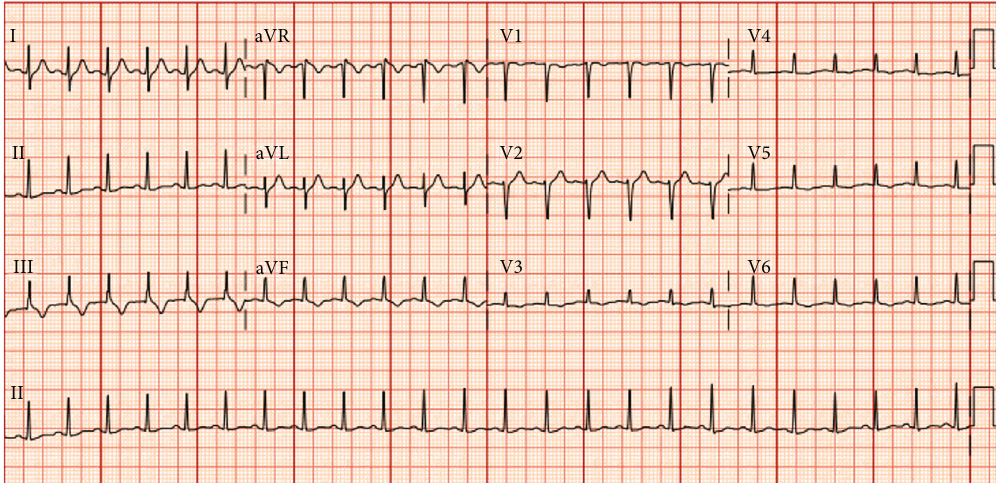
Figure 1: ECG from day of admission demonstrating sinus tachycardia without ST-T changes.